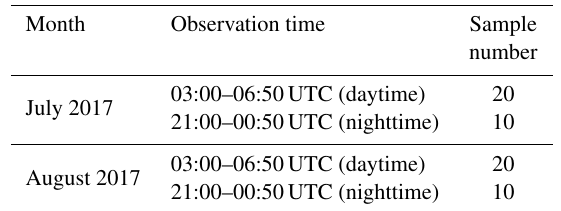
Table 1. The number of selected convective clouds during the ob- servation time.